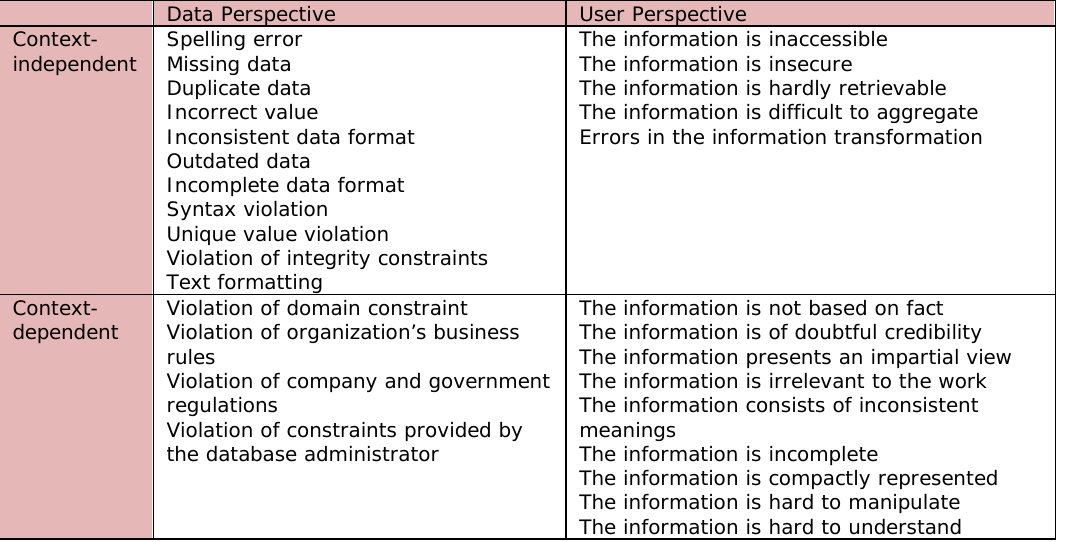
Table 2. “Classification of information quality problems identified in literature”. Source: Ge and Helfert